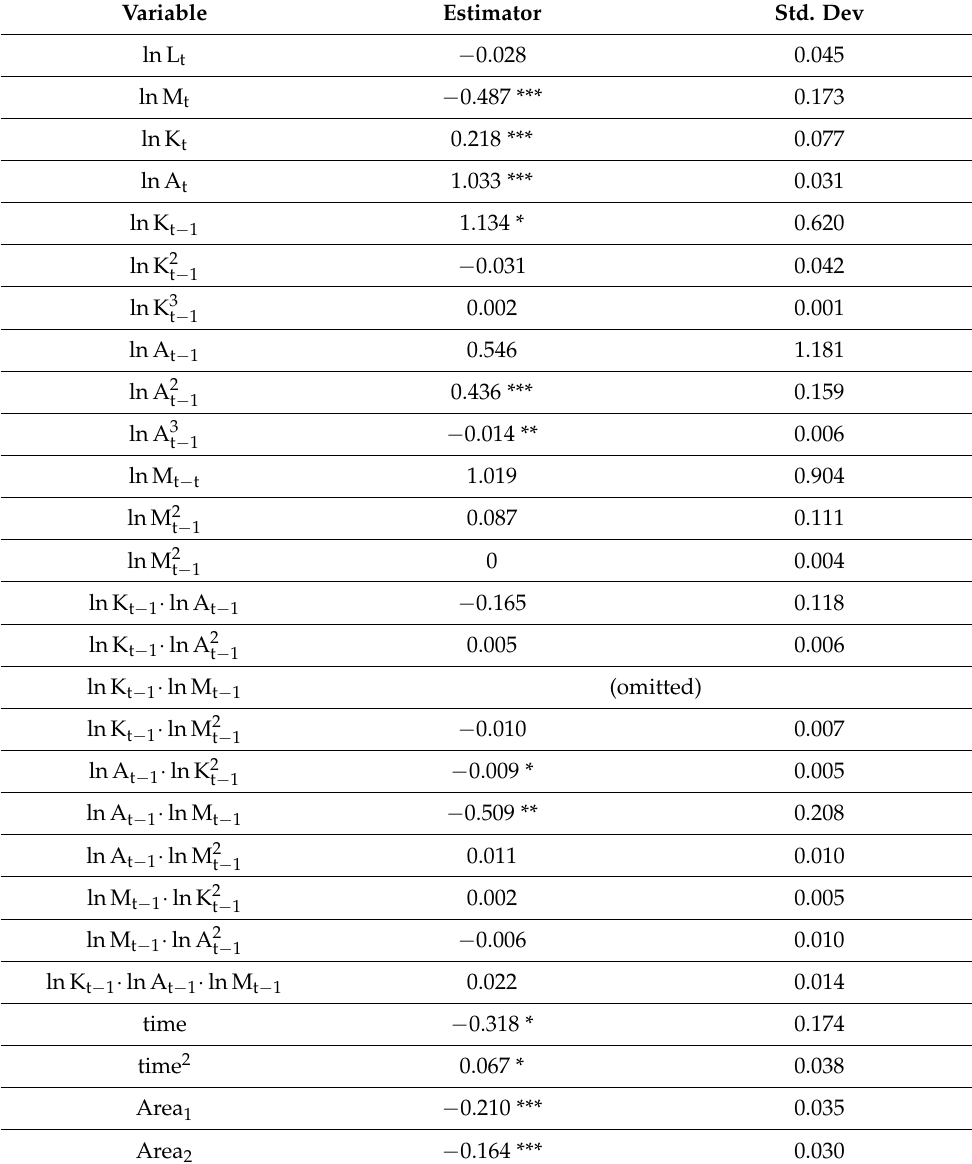
Table 11. Results of the productivity